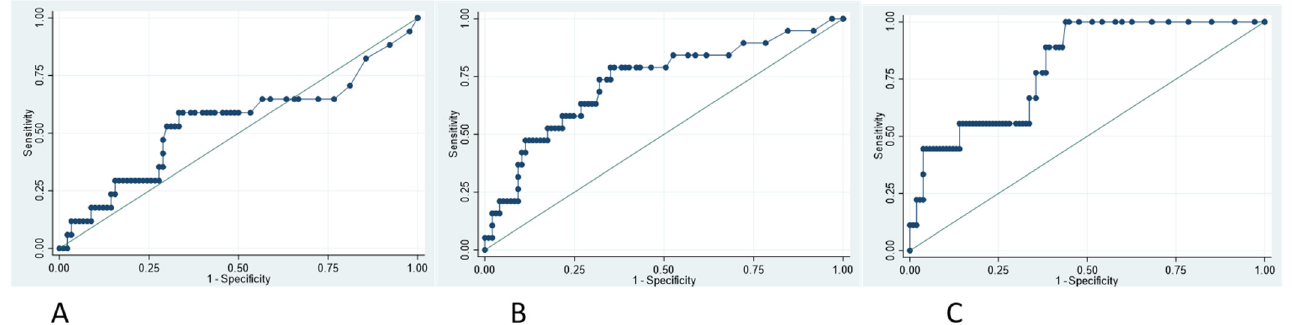
Figure 1. Receiving operator curve of PCT for ( A ): bacterial coinfection, ( B ): intensive care unit stay, and ( C ): 30 days mortality.